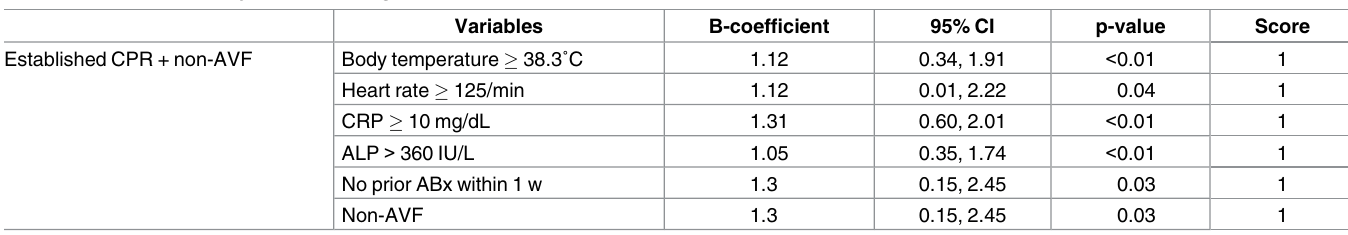
Table 5. Multivariate analysis and scoring for the modified